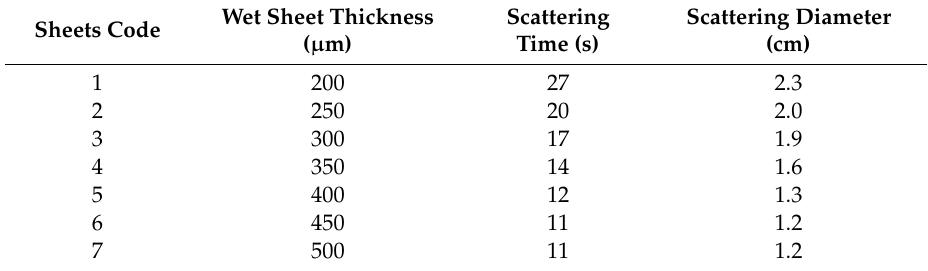
Table 2. Relationship between the thickness of wet sheet and scattering power.